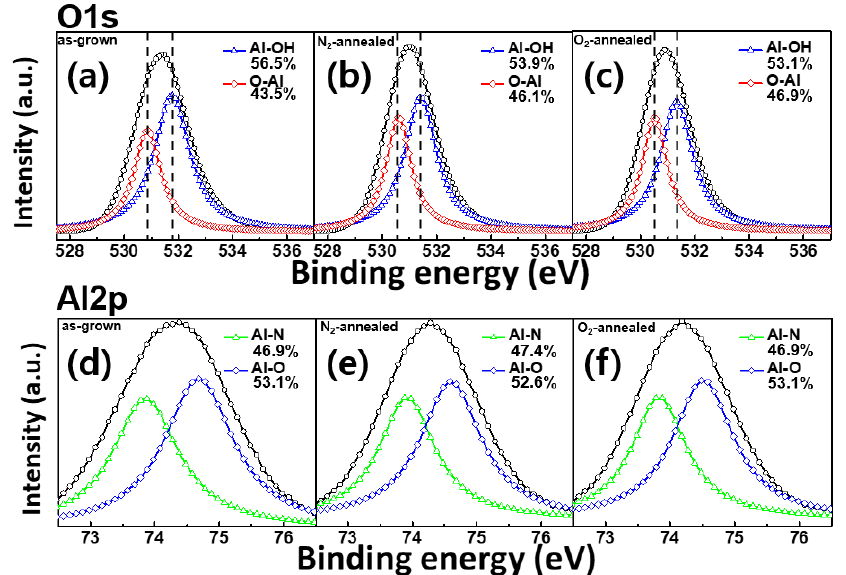
Figure 3. The results of XPS analysis of the fabricated AlN films performed before and after annealing; ( a – c ) the O 1s peaks of the various AlN films where ( a ) relates to the as-grown sample, ( b ) the N 2 - annealed sample, and ( c ) the O 2 -annealed sample; ( d – f ) the Al 2p peaks with Al–N and Al–O sub-peaks of the different samples, with results in ( d ) for the as-grown sample ( e ), the N 2 -annealed sample, and ( f ) the O 2 -annealed